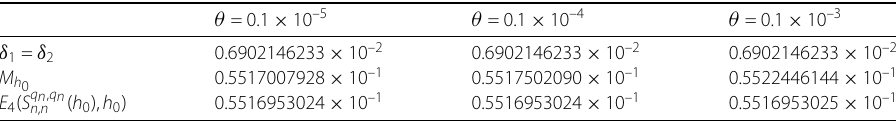
Table 4 The approximation error of S q n , q n n , n ( h 0 ) to h 0 by means of the Lipschitz functions on I R for